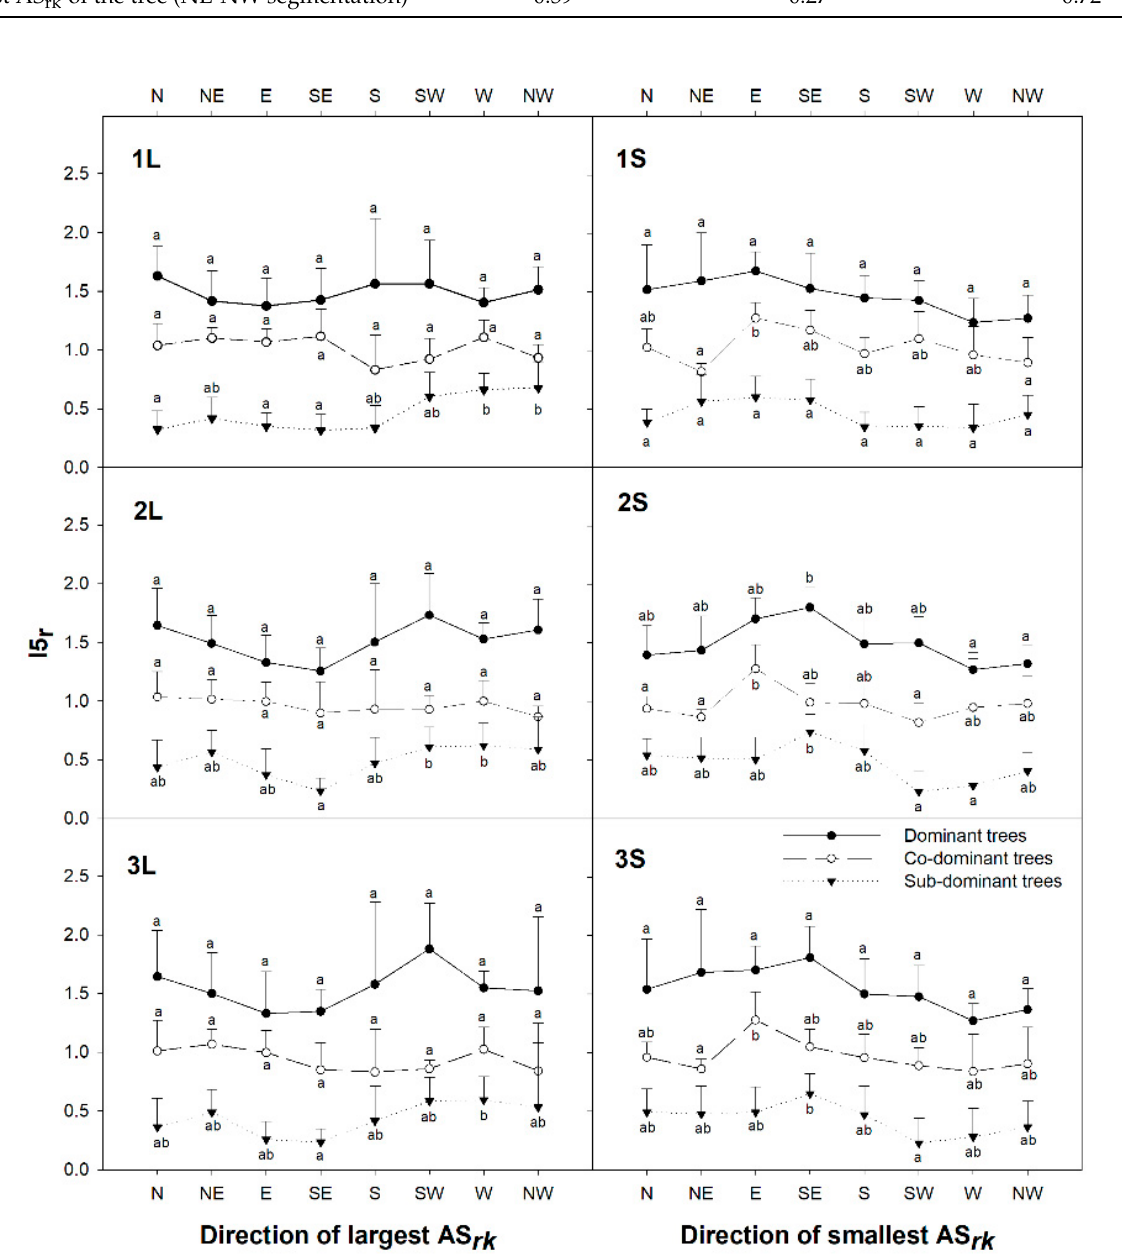
Figure 7. The means of relative 5-year radial increments (I5 r ) with a 95% confidence interval. The 1–3 in the figure follow the filtering approaches in Figure 4 (i.e., 1—trees having some large part of AS; 2—trees having some scheme. 3—trees having both large and small parts of AS). L represents an evaluation of the growth according to the direction of the lowest competition and S represents an evaluation of the growth according to the direction of the highest competition in relative ninety-degree social area sectors. Different letters denote significant differences ( p < 0.05) between the orientation of AS rk (within tree size classes) using Tukey’s post-hoc